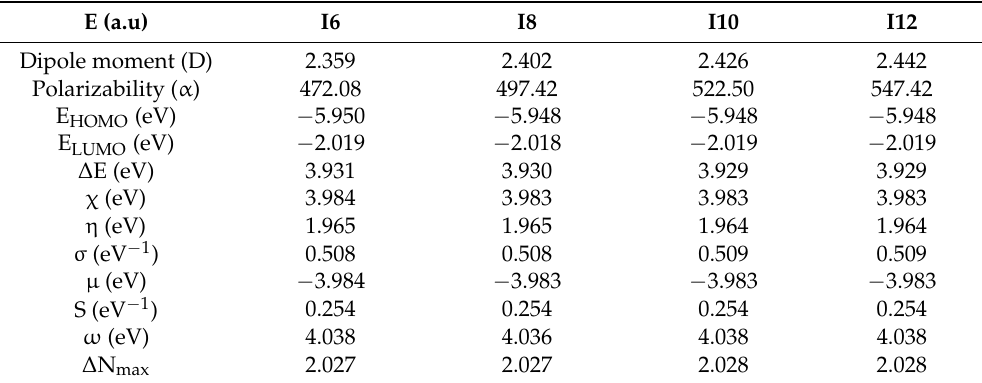
Table 3. Various quantum chemical parameters for the optimized structures of the studied molecules at B3LYP/6-31+G(d,p) level of theory.